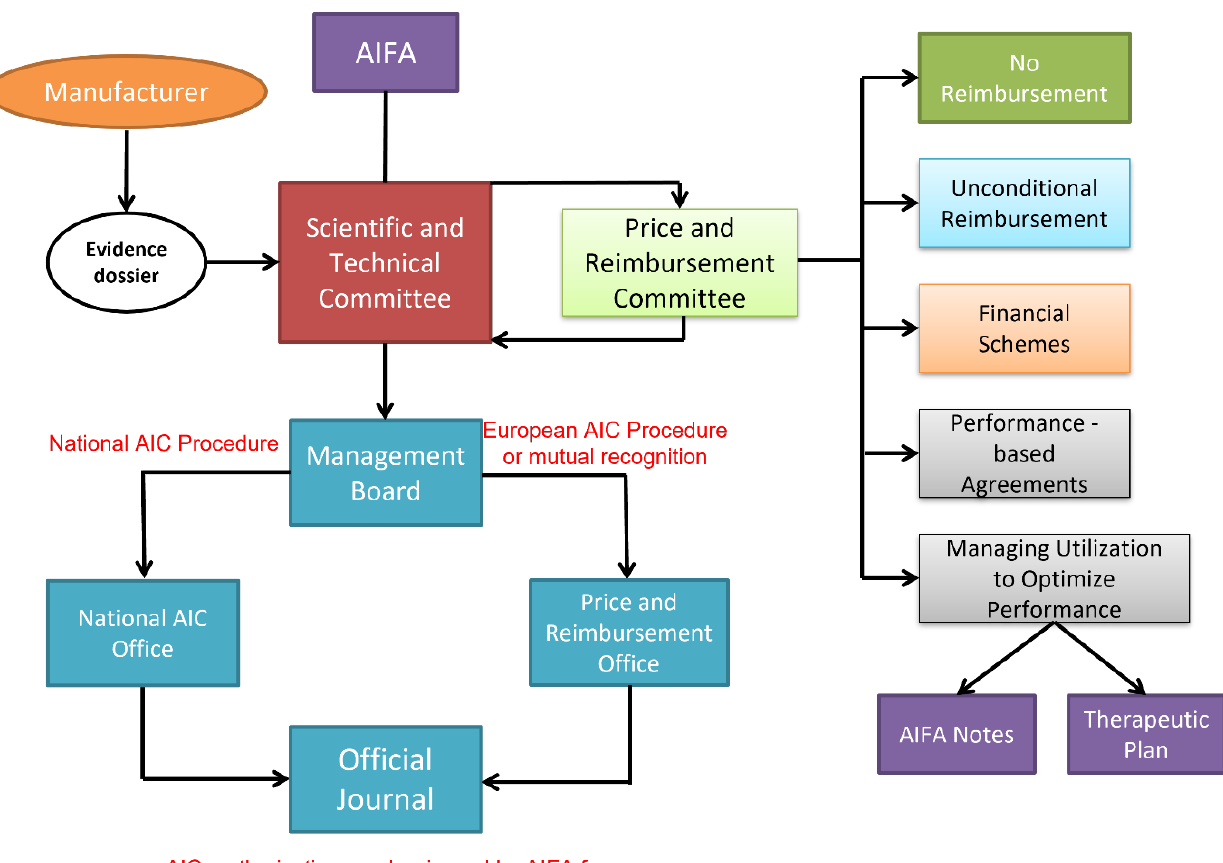
Figure 8. The Italian price and reimbursement process and the panel of different managed agreements that are available.